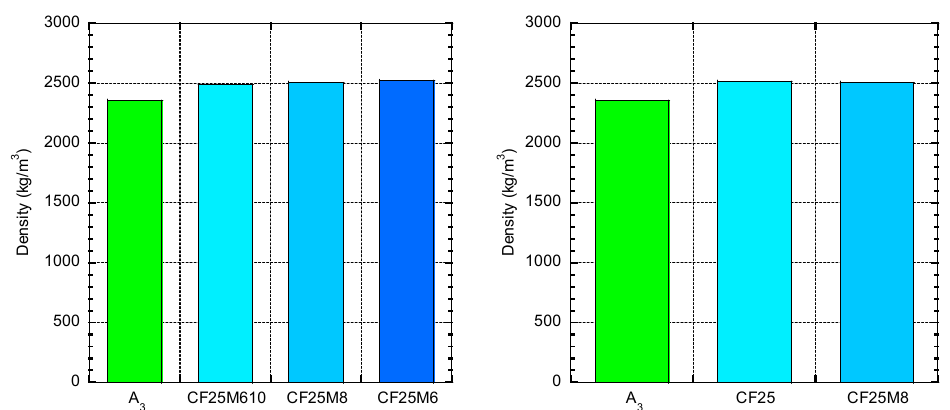
Figure 7. Density of concrete containing different percentages of micro-silica ( left ) and optimal density of concrete for each of the previous parts ( right ).